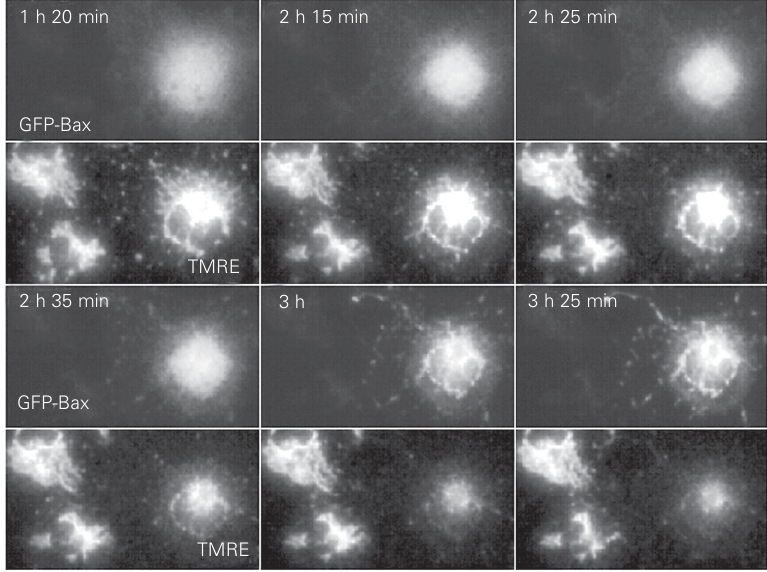
Figure 2. Loss of mitochondrial membrane potential ( (cid:1)(cid:2) m ) is associated with Bax transloca- tion to mitochondria. Healthy Cos-7 cells expressing GFP-Bax (rows 1 and 3) were co- stained with tetramethylrhodamine ethyl ester (TMRE, 50 nM) for (cid:1)(cid:2) m visualization (rows 2 and 4). Cells were then treated with the apoptotic inducer staurosporine (STS, 1 µM) and fluorescences of GFP-Bax and TMRE were simultaneously recorded. The cells on the right were transfected with GFP-Bax (rows 1 and 3) while two others on the left were not transfected with GFP-Bax but were stained with TMRE (rows 2 and 4). In the first panel at a specific time (1 h and 20 min) after STS treatment, Bax (row 1) was still soluble in the cytosol and the (cid:1)(cid:2) m (row 2) was well maintained. Over time, GFP-Bax shifted from a diffuse cytosolic state to a punctuated mitochondrial-bound localization (row 3). The presence of GFP-Bax in the mitochondria promoted the collapse of (cid:1)(cid:2) m as indicated by the decrease in TMRE fluorescence (row 4). This loss may occur concomitantly with GFP-Bax translocation to mitochondrial membranes. In the two untransfected cells the collapse of (cid:1)(cid:2) m was